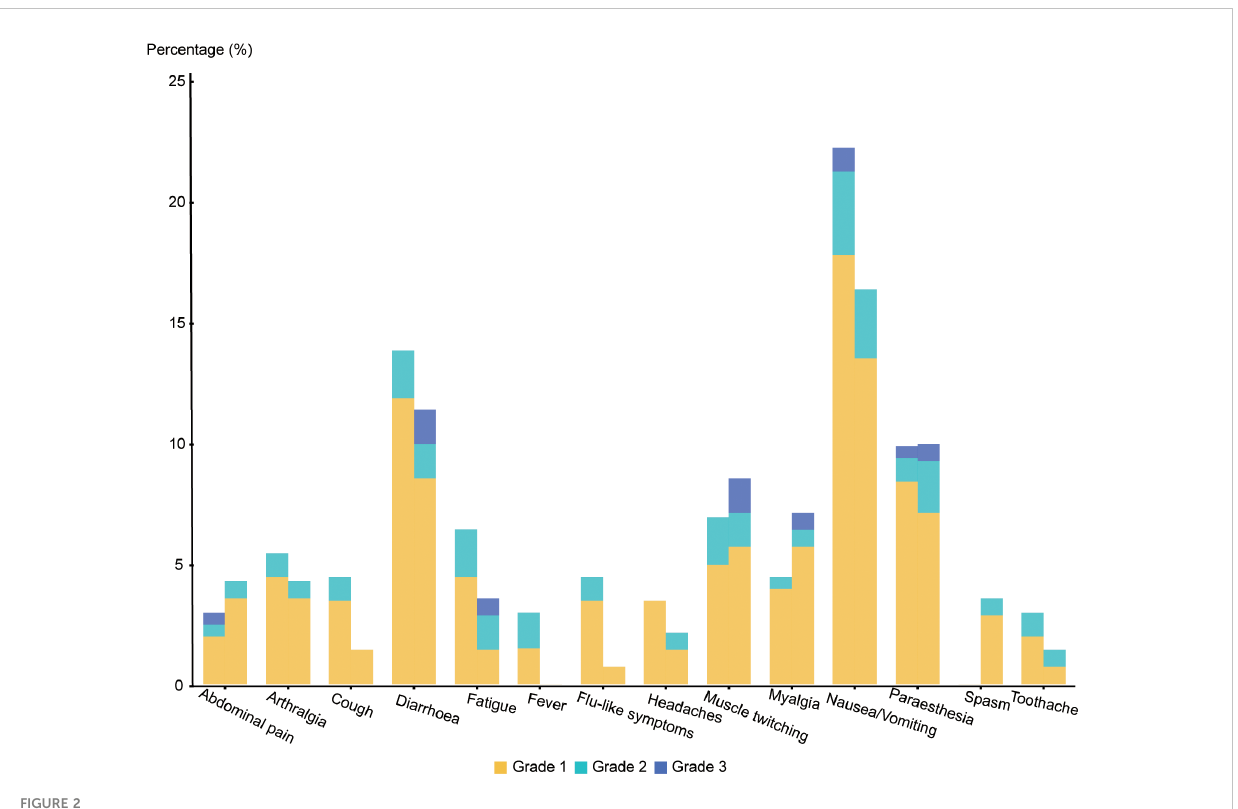
FIGURE 2 Related systemic adverse events between two